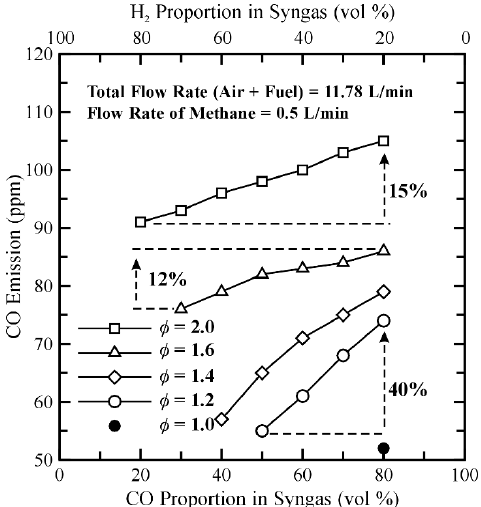
Figure 10. CO emission of CH 4 /syngas/air premixed impinging flames with varied equivalence ratios and H 2 /CO proportions.